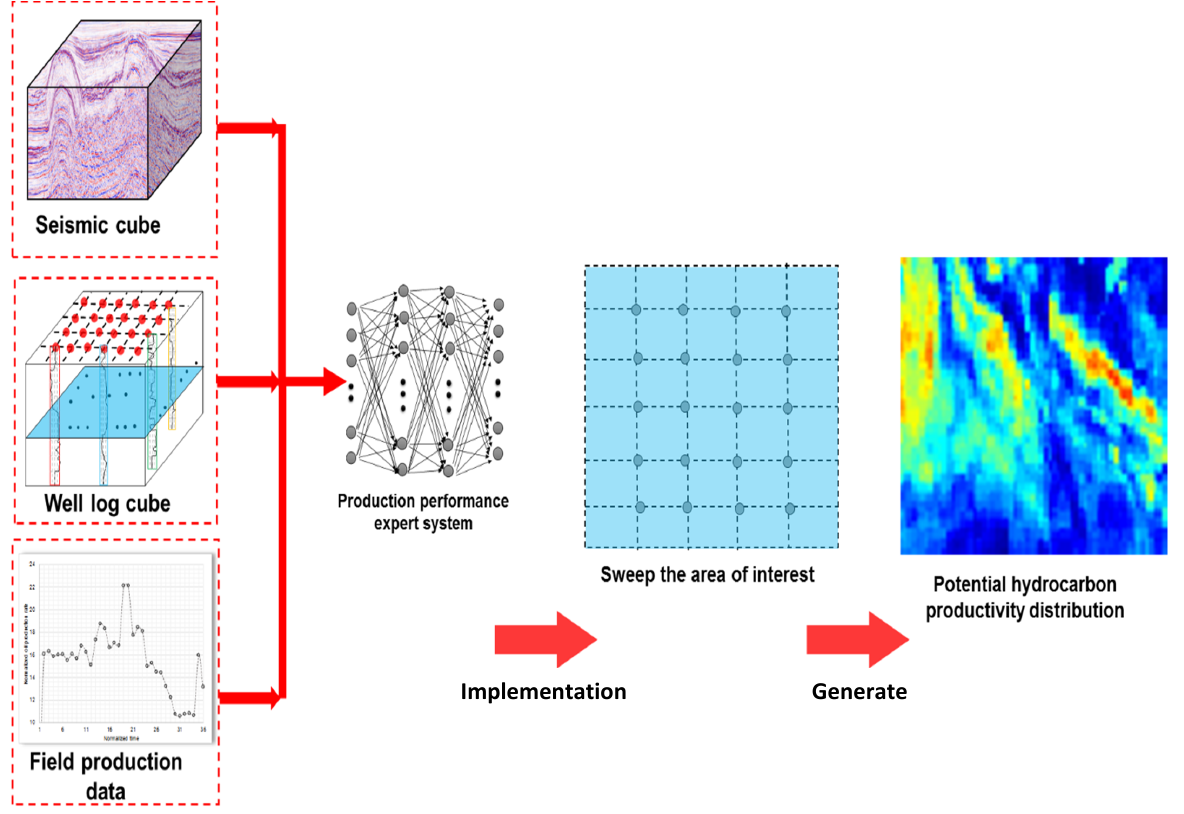
Figure 14. Schematic representation of the workflow for the second tool.